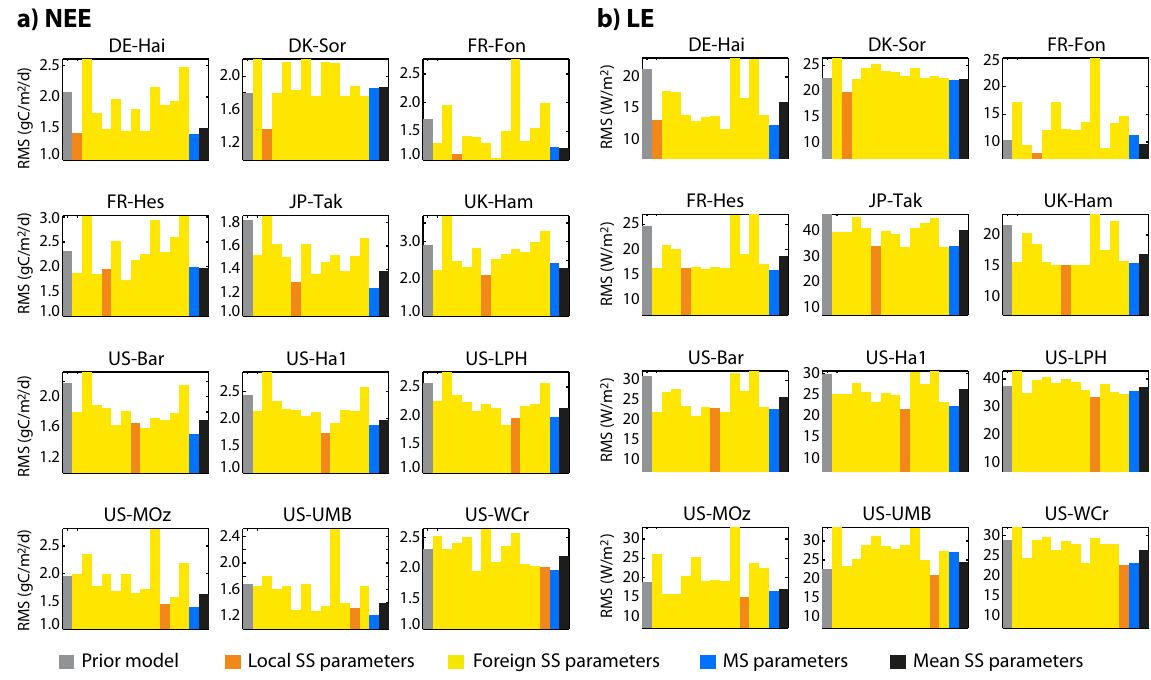
Fig. 6. Daily model-data RMSs for (a) NEE and (b) LE. For each site, one bar corresponds to the results from one set of the 21 parameters: prior model (grey), parameters from SS optimizations at the other sites (yellow), local SS optimization in orange, MS optimization (blue), mean of the SS sets of parameters (black).